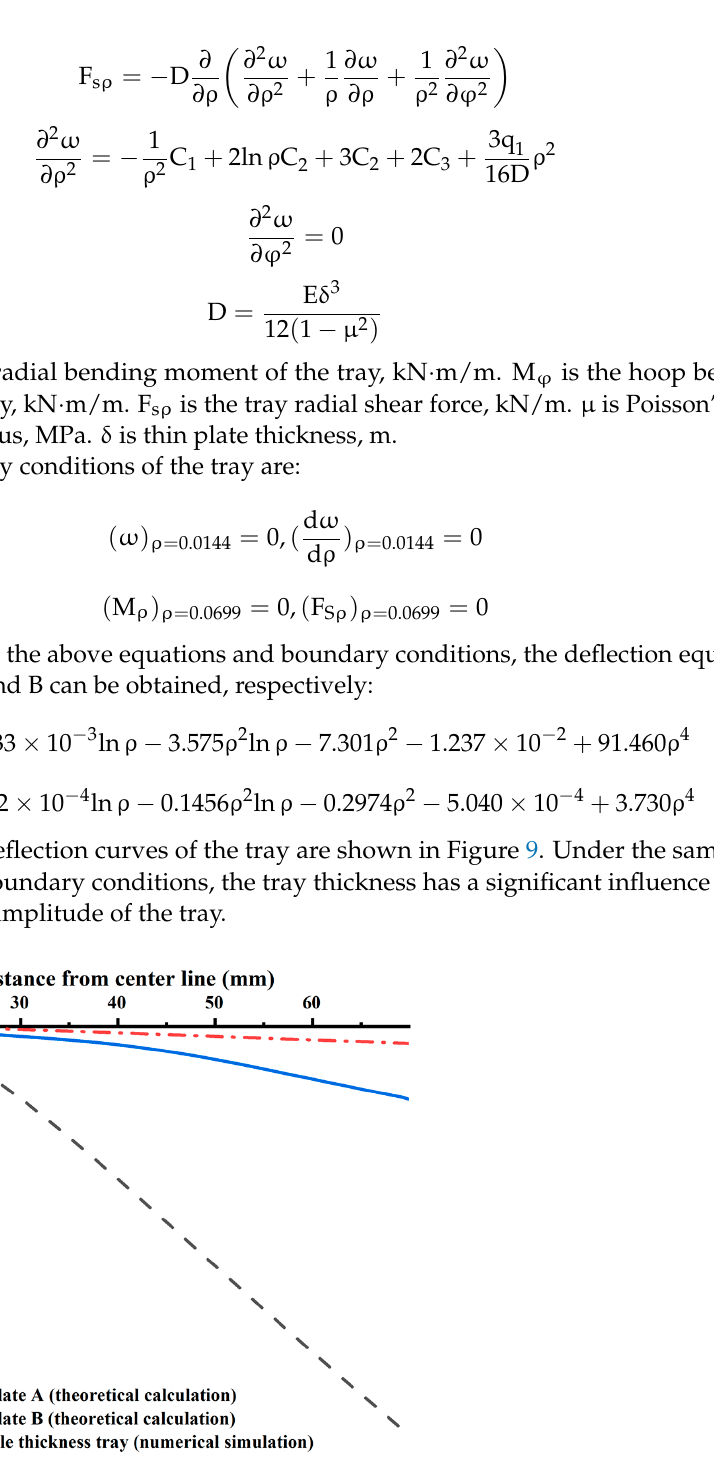
Figure 9. Comparison of radial deflection curves between theoretical analysis and numerical simulation. When the thickness is reduced by 2.9 times from 35.34 mm to 12.16 mm, the deflection at the tray edge increases by 24.5 times from 0.30 mm to 7.35